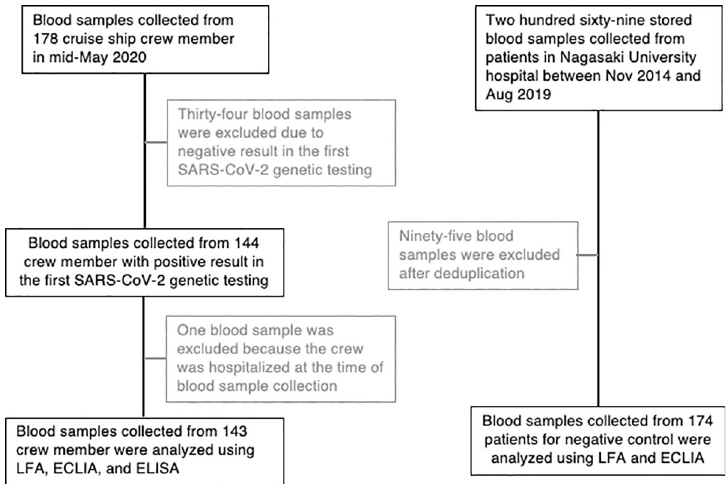
Fig 1. Participant flow diagram. SARS-CoV-2, severe acute respiratory syndrome coronavirus 2; LFA, lateral flow immunochromatographic assay; ECLIA, electrochemiluminescence immunoassay; ELISA, enzyme-linked immunosorbent